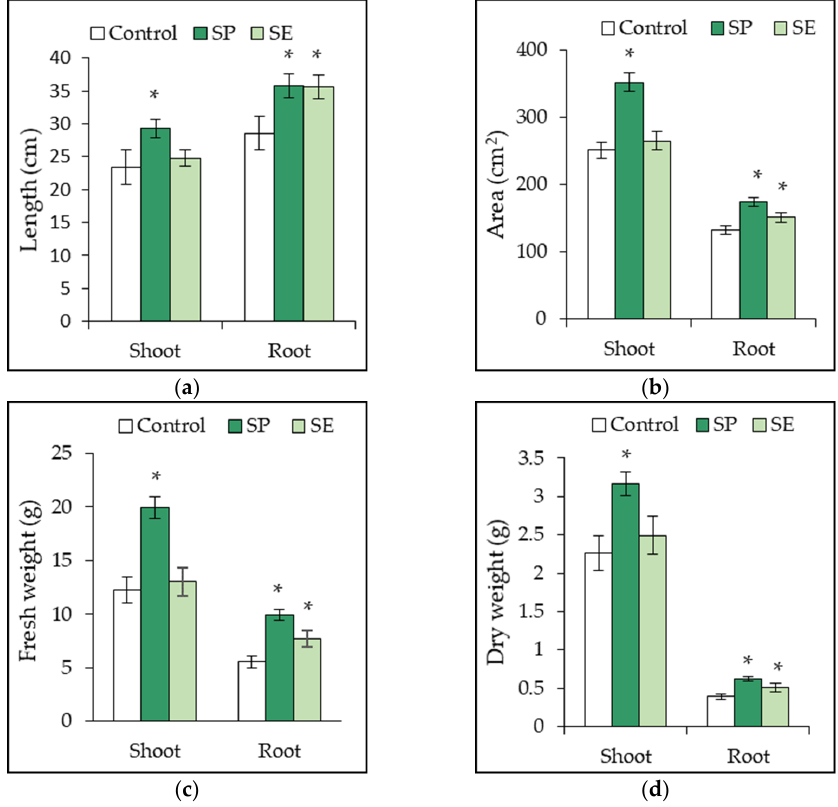
Figure 2. Morphological parameters of ( a ) length, ( b ) area, ( c ) fresh weight and ( d ) dry weight of 45-day-old tomato plants treated with seaweed powder (SP) and seaweed extract (SE) from Ulva ohnoi . Values represent mean ± standard deviation (n = 12 plants). Asterisks (*) over the bars indicate significant differences of each treatment in comparison to the control (untreated plants), based on the Holm–Sidak means comparison test ( p < 0.05).